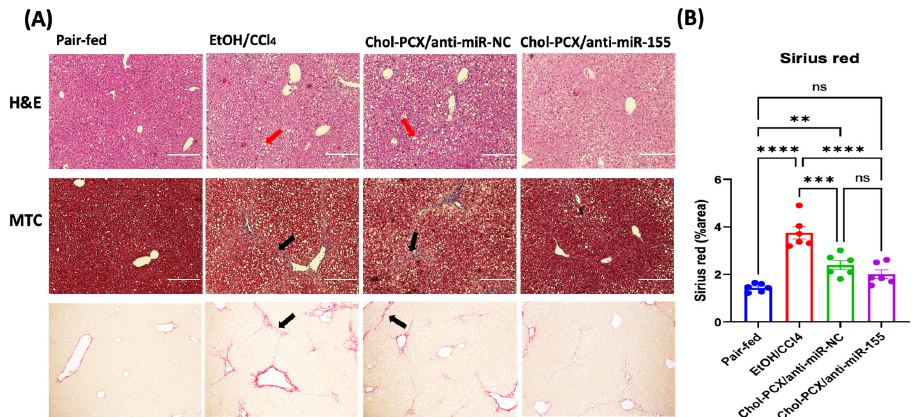
Figure 10. Therapeutic efficacy of Chol-PCX/anti-miR-155 in AALD fibrosis. ( A ) Hematoxylin and eosin stain (H&E), Masson’s trichrome stain (MTC), and Sirius Red stain for liver tissues in different groups. Red arrows in H&E represent fat droplets, black arrows in MTC or Sirius Red represent bridging fibrosis. ( B ) Sirius Red quantification for collagen deposition by ImageJ. Data were analyzed by one-way ANOVA followed by Tukey’s comparison test. Data are expressed by mean ± SEM. ** p < 0.01, *** p < 0.001, and **** p < 0.0001.